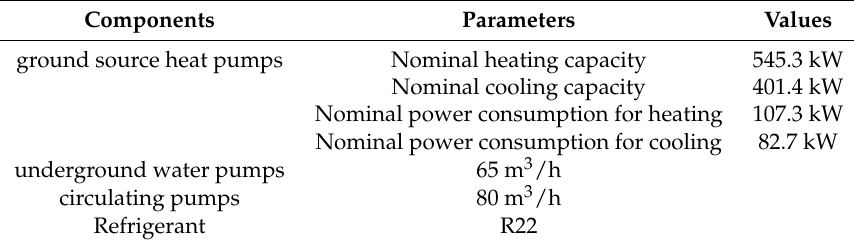
Table 1. Specifications of the GSHP